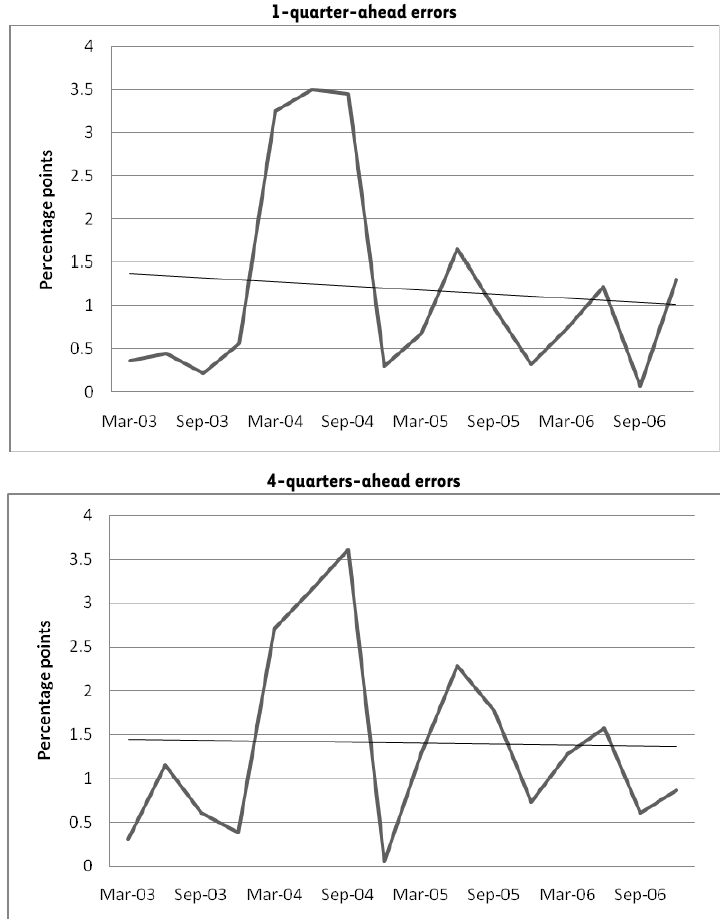
FIGURE 12 GDP forecast errors, 2003-2006